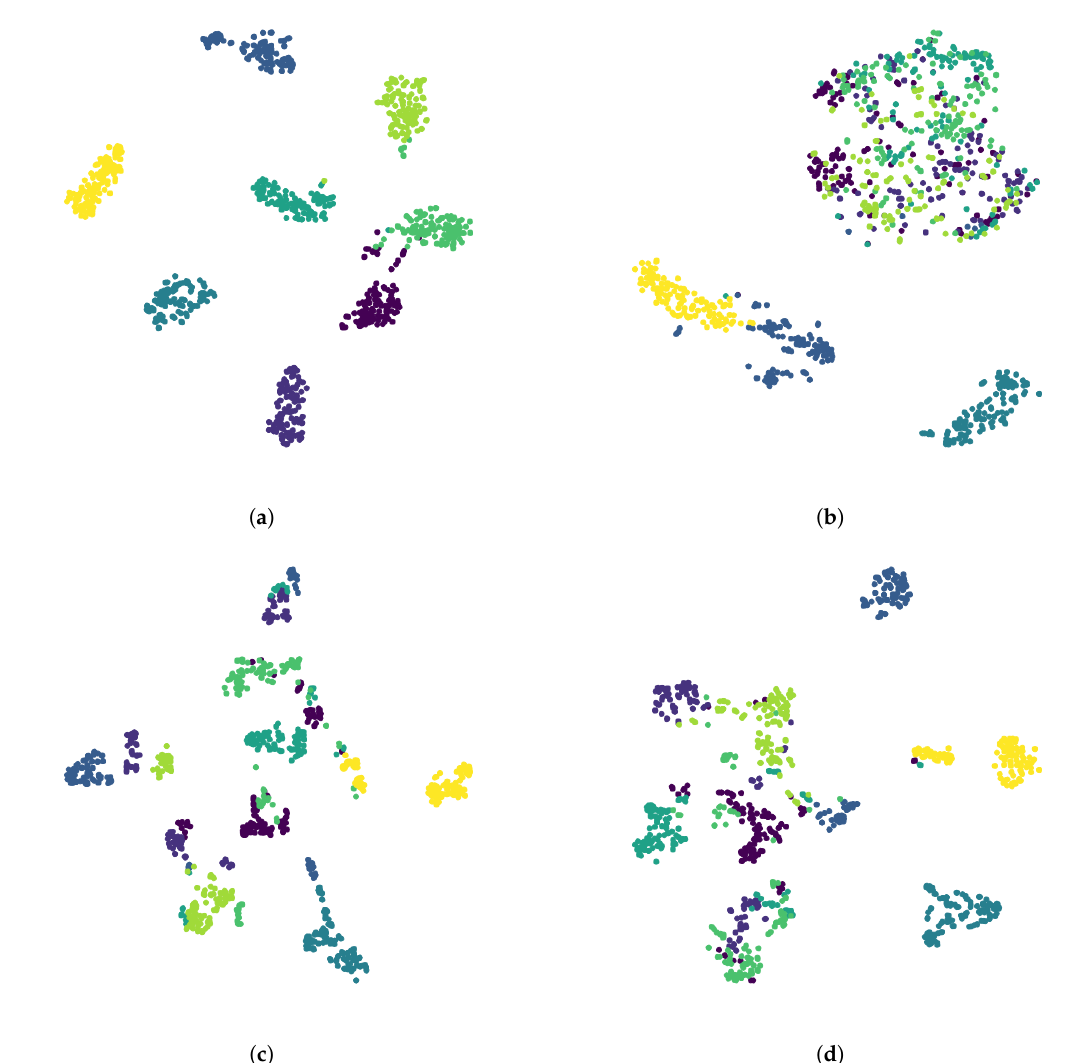
Figure 6. The visualisation of the learned parameters for four networks introduced in Section 2.5.4. Each point represents given sample’s activations transformed to the two-dimensional space using t-SNE algorithm. Different colors represent different classes present on the image. ( a ) Activations from network trained using 200 samples/class; ( b ) Activations from network trained using 5 samples/class; ( c ) Activations from network trained using artificial labels only; ( d ) Activations from network trained with fine-tuning (artificial followed by training